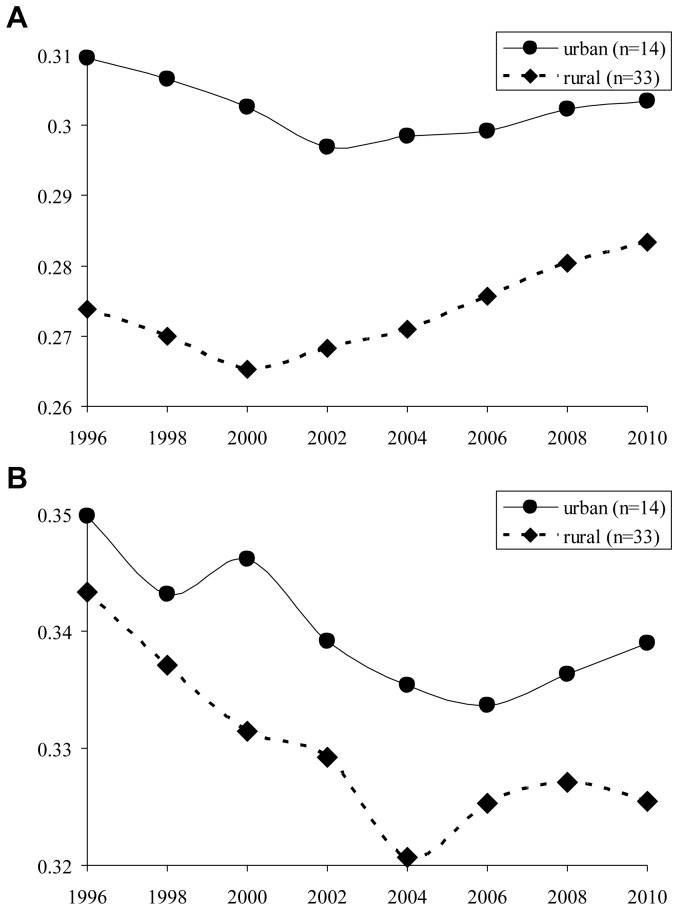

Figure 3-a; Mean of Gini coefficient of all physicians in intra-prefectural distributions; Prefectures were classified into urban and rural according to the metropolitan area codes.
Figure 3-b; Mean of Gini coefficient of pediatricians in intra-prefectural distributions; Prefectures were classified into urban and rural according to the metropolitan area codes.